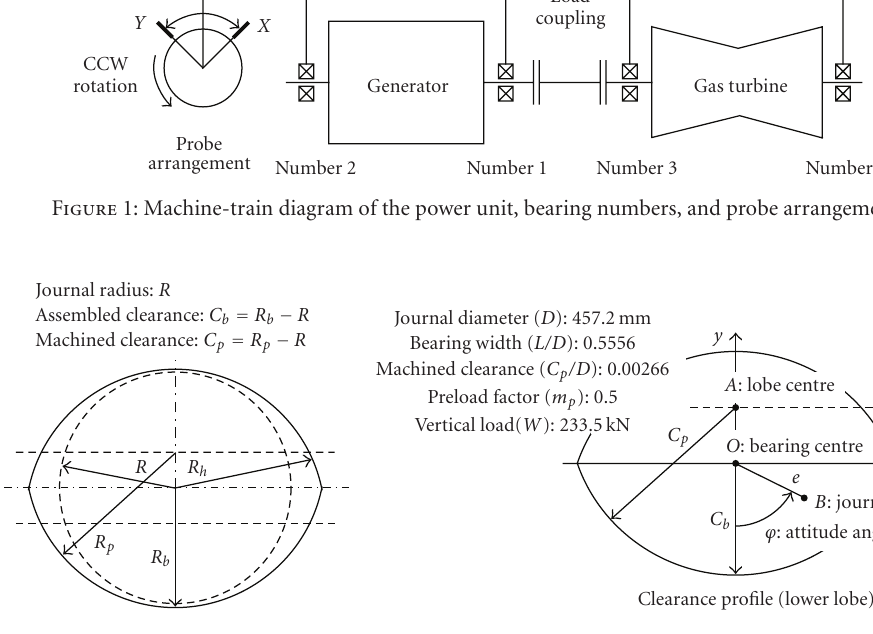
Figure 2: Basic geometric parameters of the elliptical journal bearing no.